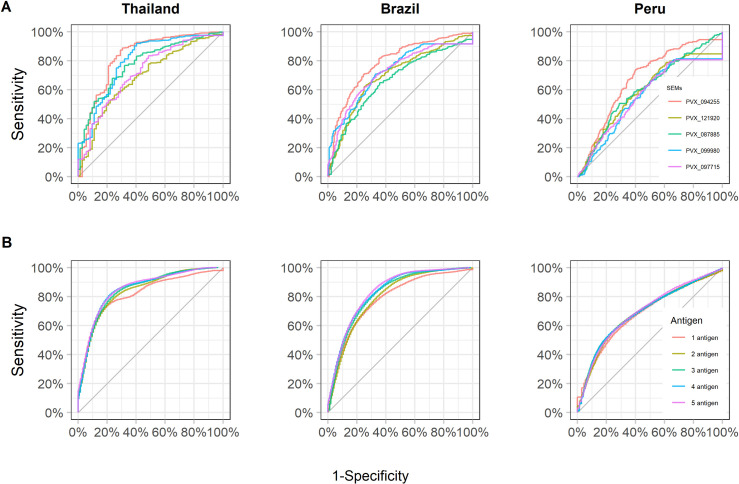
Diagnostic performance for classifying recent exposure using antibody responses.(A) Receiver operating characteristic (ROC) curve displays the diagnostic performance of 5 top antibody responses individually: PVX_094255 (PvRBP2b), PVX_121920 (PvRBP2a), PVX_087885 (PvRAMA), PVX_099980 (PvMSP119) and PVX_097715 (hypothetical PvMSP3) in the study sites. (B) ROC curves displaying the diagnostic performance to detect recent infections given by combinations of the top 5 antibody responses.